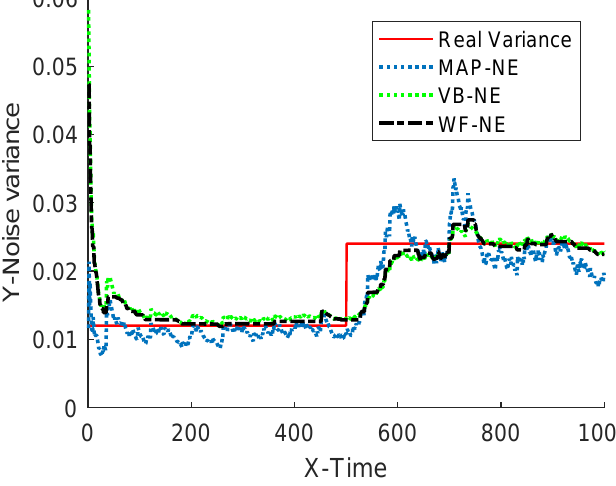
Figure 4. Estimation of measurement noise variance.